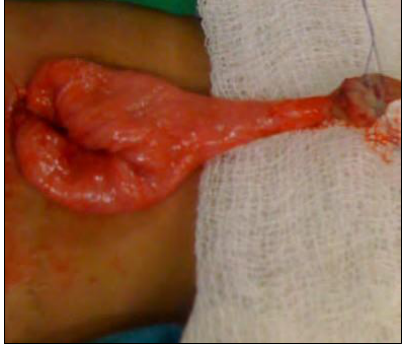
Figure 6: Sometimes conduit undergoes excessive growth in length. On the other hand, if the blood supply is inadequate it may shrivel and get